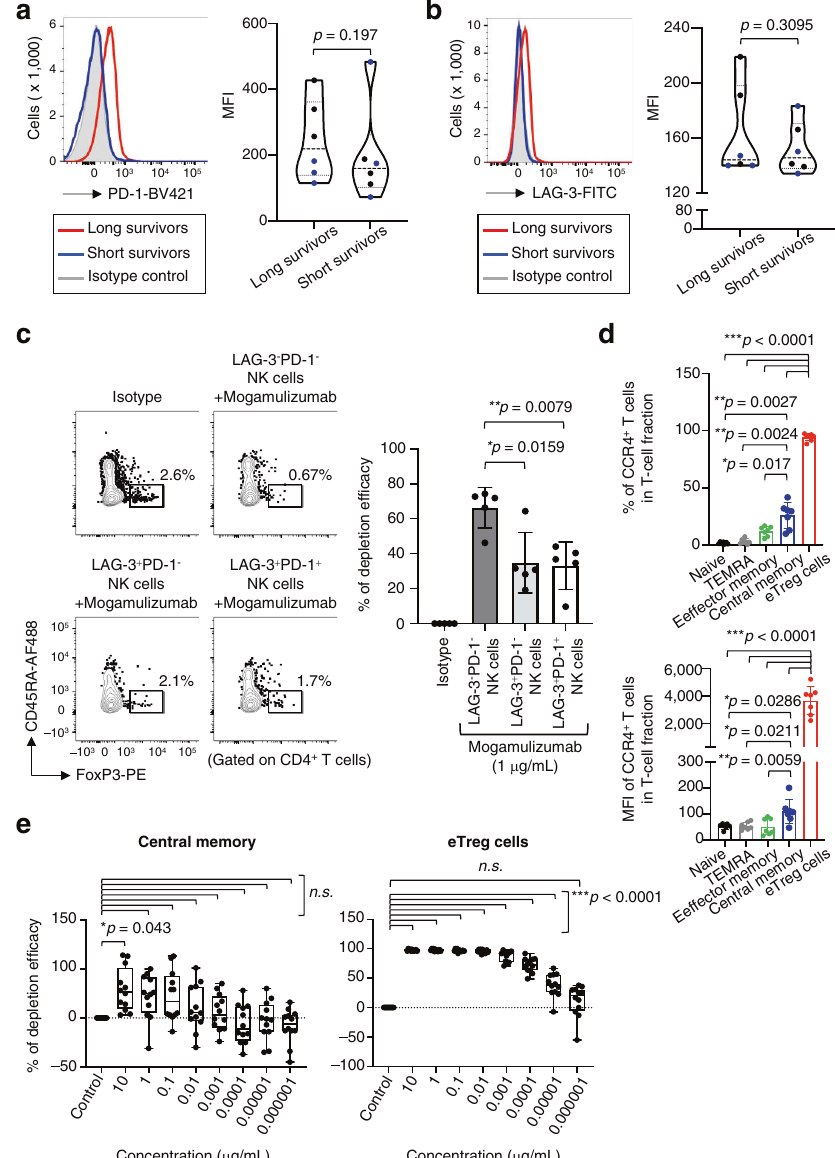
Fig. 5 NK cells exhibit an exhausted phenotype in long survivors. a , b Representative fl ow cytometry staining (left) for PD-1 ( a ) and LAG-3 ( b ) in NK cells and summaries (right) for the frequencies of NK cells at pre-mogamulizumab treatment (PD-1, p = 0.197 and LAG-3, p = 0.3095) in long survivors ( ≥ 1 year) and short survivors (< 1 year) are shown. PBMC samples (long survivors: n = 6, short survivors: n = 6), as in Fig. 4, were subjected to fl ow cytometry. c The distinct ADCC activity by exhausted NK cells. LAG-3 - PD-1 - , LAG-3 + PD-1 - and LAG-3 + PD-1 + NK cells derived from PBMCs of healthy individuals ( n = 5) were co-cultured with CD4 + T cells in the presence of mogamulizumab, and reduction of eTreg cells was examined. Representative fl ow cytometry data (left) and summary for depletion ef fi cacy of eTreg cells (LAG-3 + PD-1 - NK cells, * p = 0.0159 and LAG-3 + PD-1 + NK cells, ** p = 0.0079) are shown (right). d The frequencies of CCR4-expressing cells (top) and expression levels (mean fl uorescence intensity: MFI) of CCR4 (bottom) in each CD8 + T cell fraction and eTreg cells in PBMCs from healthy individuals ( n = 7). The differences between each CD8 + T cell fraction and eTreg cells were *** p < 0.0001 in the frequencies and the expression levels. The differences between central memory CD8 + T cells and Naive CD8 + T cells, and effector memory CD8 + T cells, and TEMRA CD8 + T cells were ** p = 0.0027, * p = 0.017 and ** p = 0.0024, respectively in the frequencies of CCR4-expressing cells; were * p = 0.0286, ** p = 0.0059 and * p = 0.0211, respectively in the expression levels of CCR4. e Reduction of central memory CD8 + T cells (left) and eTreg cells (right) after mogamulizumab treatment. PBMC samples from healthy individuals ( n = 12) were cultured with the indicated dose of mogamulizumab. Changes in each T cell fraction were examined (10 µ g/mL, * p = 0.043 in central memory CD8 + T cells and 10 – 0.00001 µ g/mL, *** p < 0.0001 in eTreg cells). In ( a and b ), black dots, patients who received 1.0 mg/kg mogamulizumab; blue dots patients who received 0.1 mg/kg mogamulizumab. Naive CD8 + T cells: Naive, central memory CD8 + T cells: Central memory, effector-memory CD8 + T cells: Effector memory, TEMRA CD8 + T cells: TEMRA. In ( a and b ), one-sided Mann – Whitney test was used. In ( c ), two-sided Mann – Whitney test was used. In ( d and e ), two-sided Dunnett test was used. In ( e ), the center line indicates the median, and the box limits indicate the 1st and 3rd quartiles. The whiskers go down to the smallest value and up to the largest. * p < 0.05, ** p < 0.005, *** p < 0.0001. Source data are provided as a Source Data fi